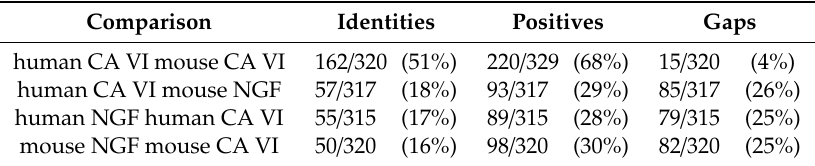
Table 1. The number of identities, positives, and gaps between the carbonic anhydrase VI (CA VI) and nerve growth factor (NGF) in mouse ( Mus musculus ) and human ( Homo sapiens ). Each pair is aligned with BLAST Global Align tool. Identities refer to same amino acids, positives refer to amino acids having similar physico-chemical properties, and gaps refer to spaces introduced to compensate insertions and